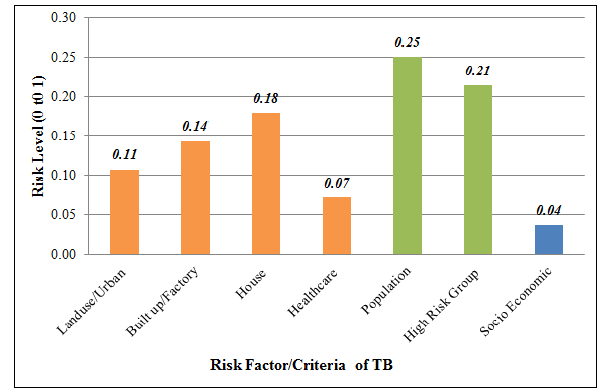
Figure 4. Risk level of the TB factors according to the selected experts’ opinion at Section U19